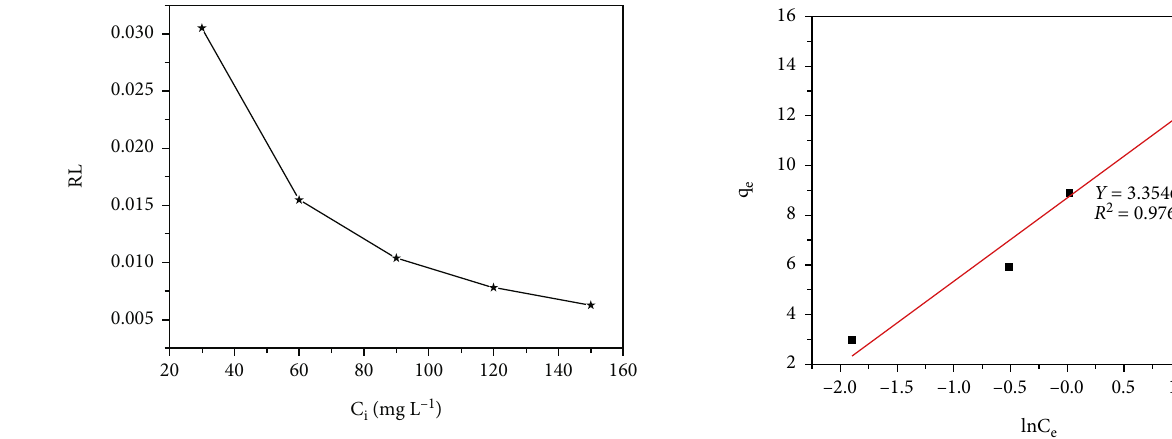
Y = 0.4623x + 0.8794 R 2 = 0.9804